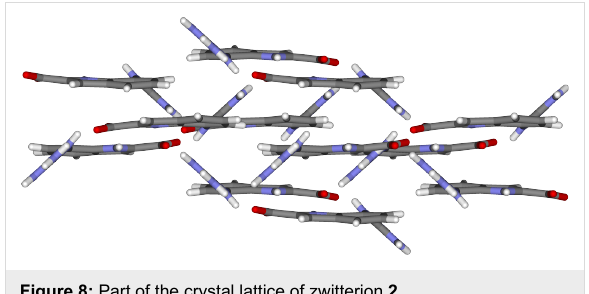
Figure 8: Part of the crystal lattice of zwitterion 2